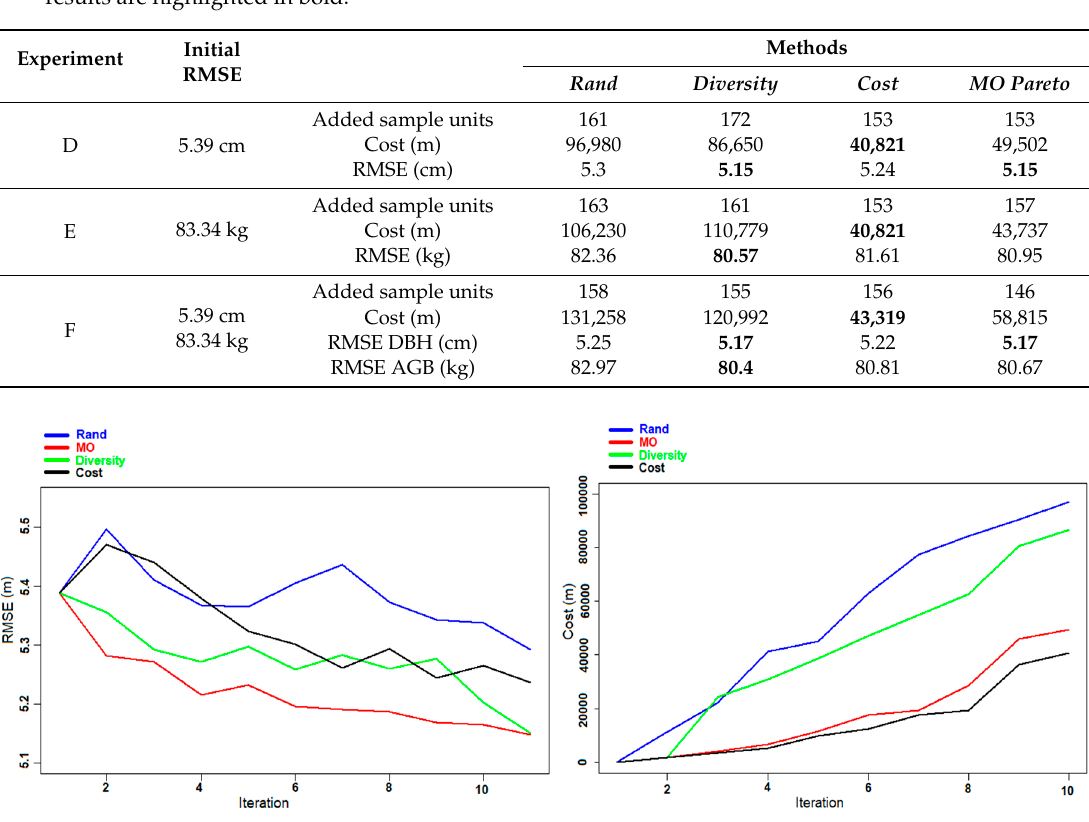
Figure 2. Experiment D: Evolution of the RMSE ( left panel ) and the cost ( right panel ) of DBH prediction for the Hadeland dataset during the different iterations.